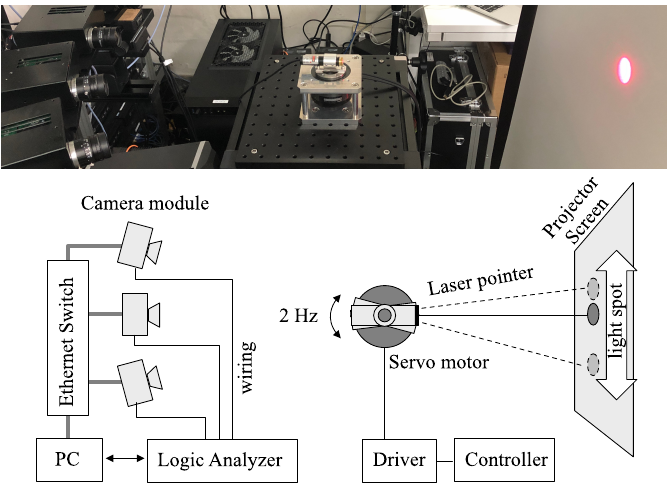
Figure 7. Outline of the experiment to evaluate the frame synchronization using light